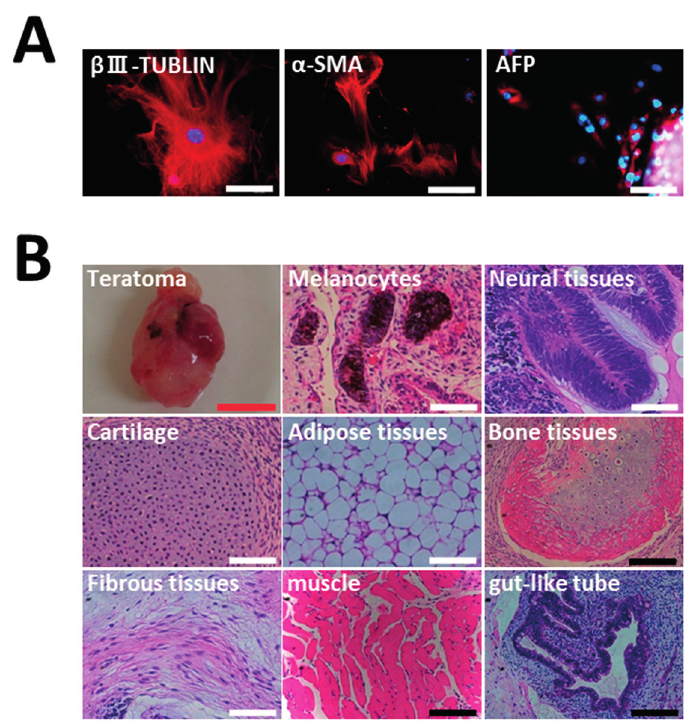
Figure 2. Induced PSCs have the potential to differentiate into three germ layers in vitro and in vivo . ( A ) Immunocytochemistry for β -III tubulin, α -smooth muscle actin ( α -SMA), α -fetoprotein (AFP) for the differentiation capacity of HGF-iPSCs 1-1 at passage 37 into embryoid bodies; ( B ) Hematoxylin and eosin staining of teratoma derived from iPSCs 1-1 at passage 36 and observation of neural tissue (ectoderm), melanocytes (ectoderm), cartilage (mesoderm), adipose tissue (mesoderm), bone tissue (mesoderm), fibrous tissue (mesoderm), muscle (mesoderm), and gut-like tube (endoderm). White scale bar = 200 μ m, red scale bar = 10 mm, black scale bar = 400